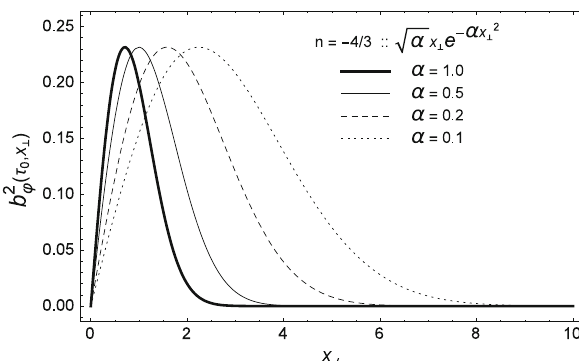
Fig. 16 (cid:5) 1 as a function of τ for different values of x ⊥